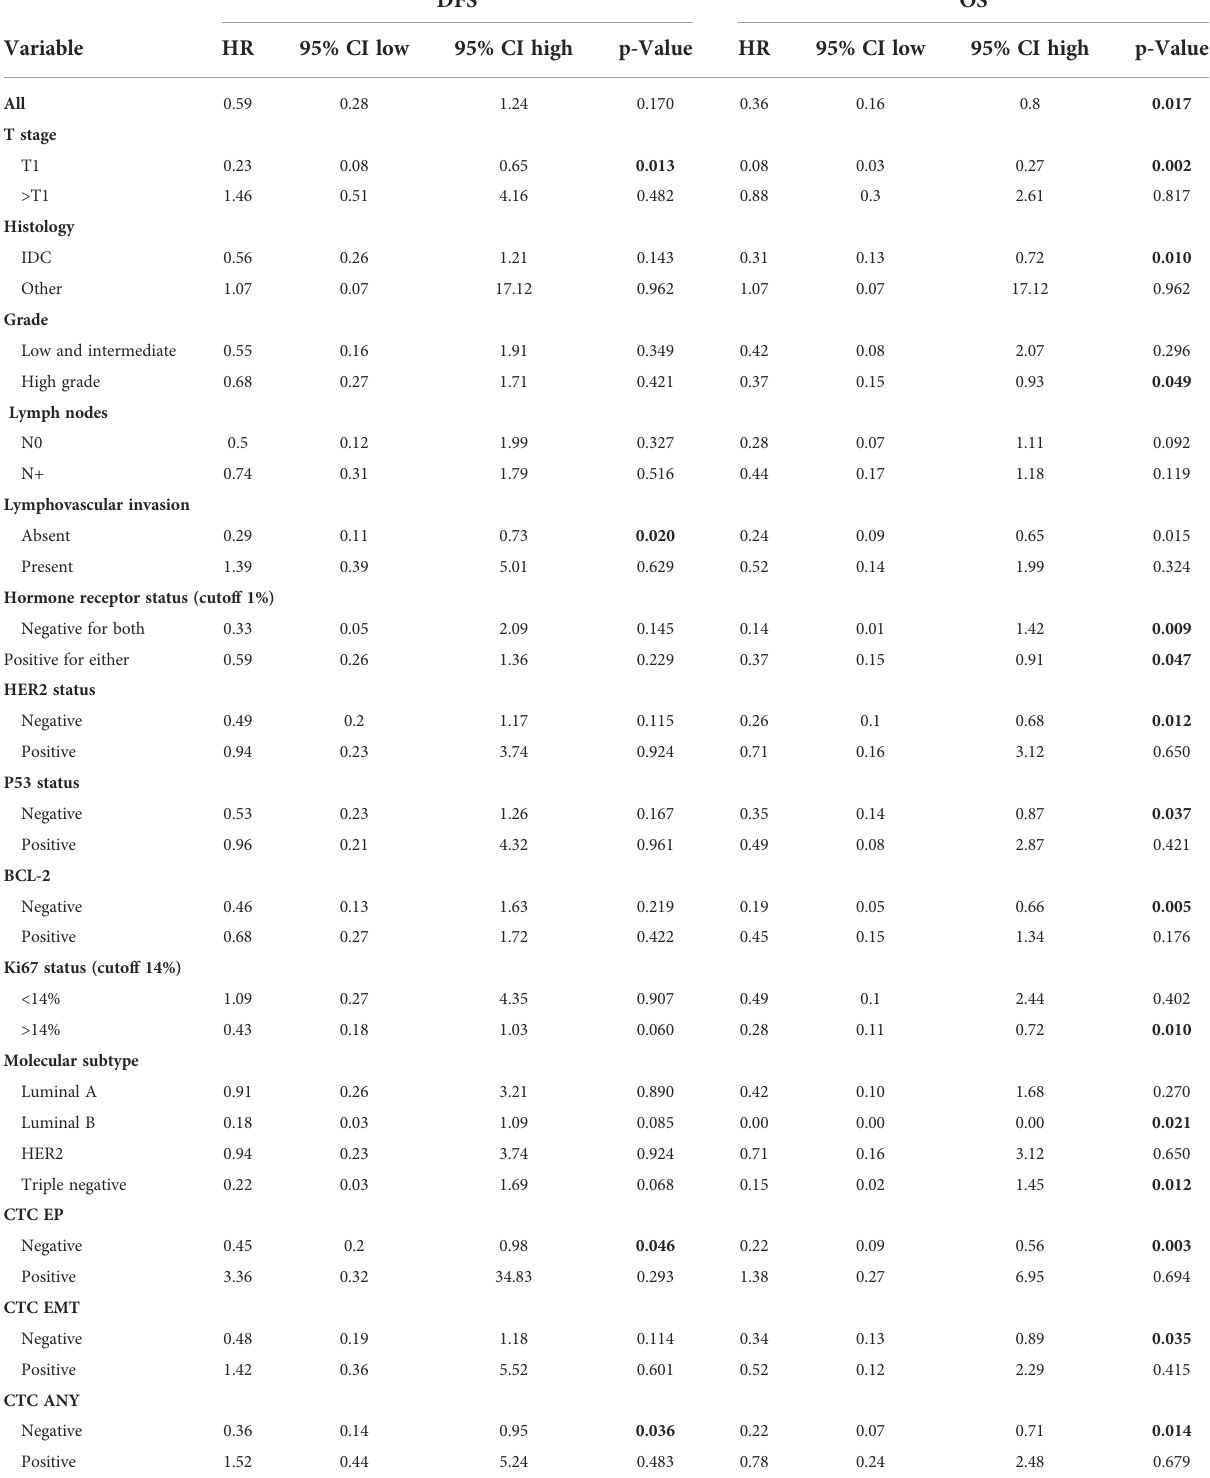
TABLE 3 Prognostic value of vitamin D on disease-free survival and overall survival in primary breast cancer (vitamin D dichotomized below vs. above median).